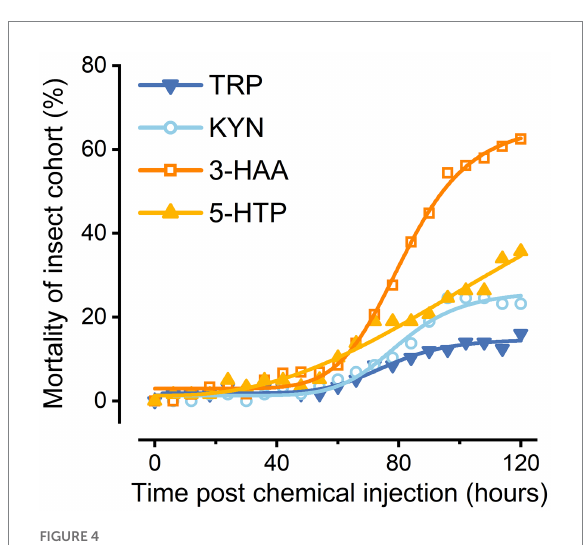
FIGURE 4 Preliminary insecticidal activity of Trp